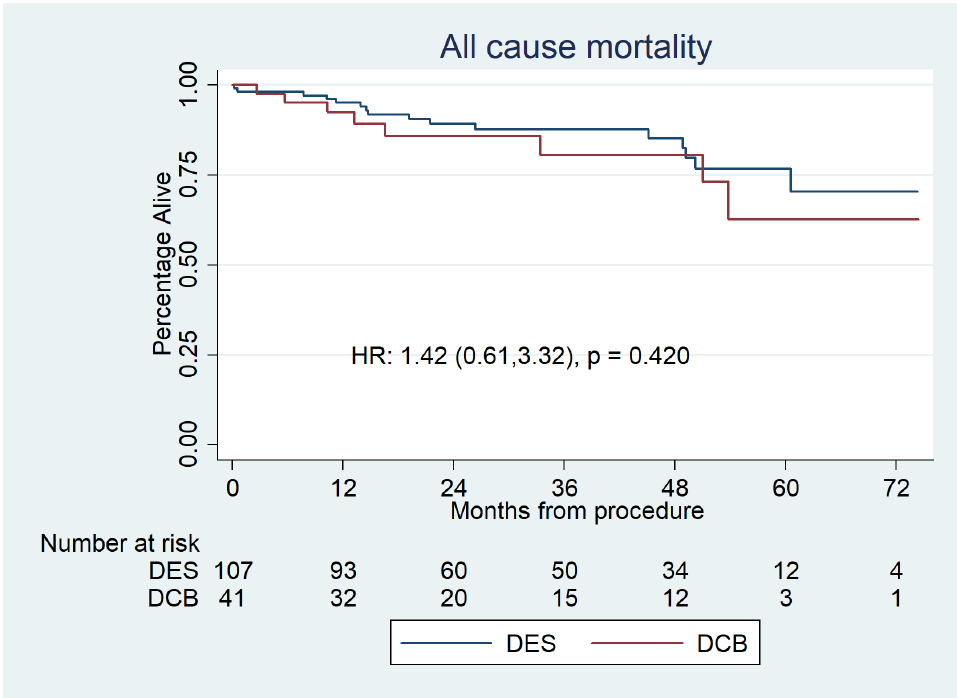
Figure 2. Kaplan–Meier estimator plot of all-cause mortality for paclitaxel DCBs vs. second-generation DESs for de novo LMS disease. The number at risk is represented at the bottom. This shows no significant difference between the groups.